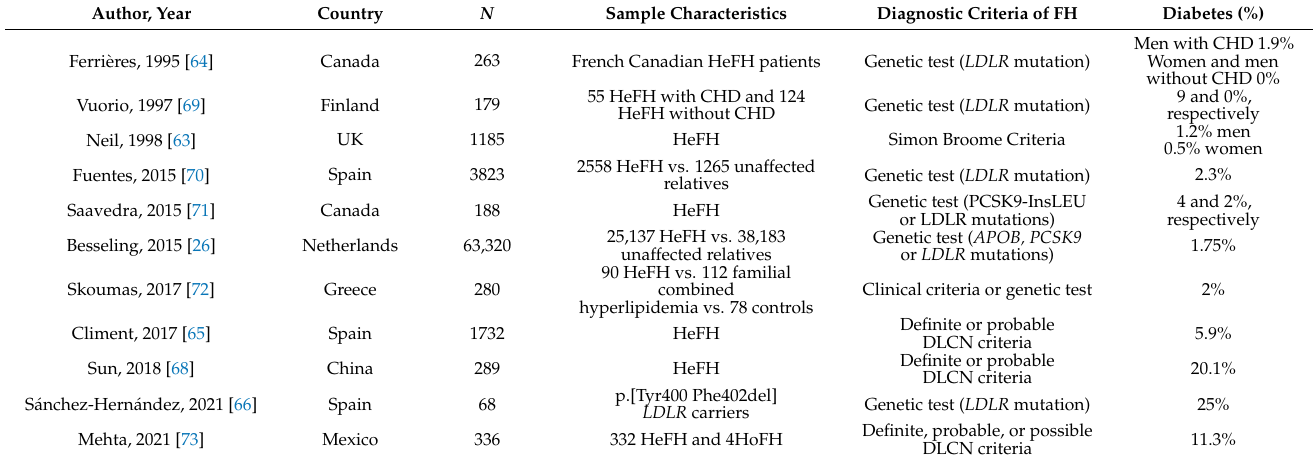
Table 1. Prevalence of diabetes in representative populations with